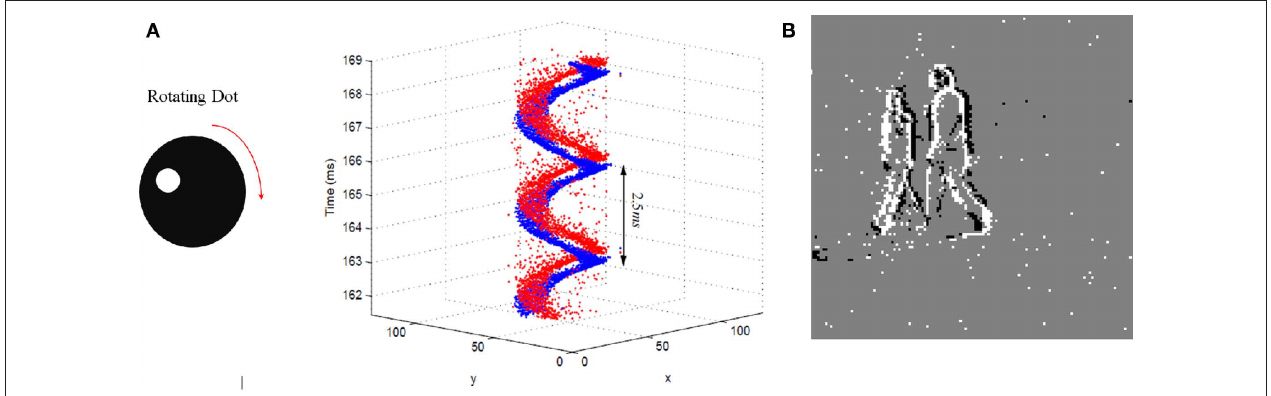
Figure 22 | illustration of Temporal Derivative retina Outputs. (A) Events produced by a rotating black disk with a white dot, represented in ( x , y , t ) coordinates. (B) Events collected during 20 ms when observing two people